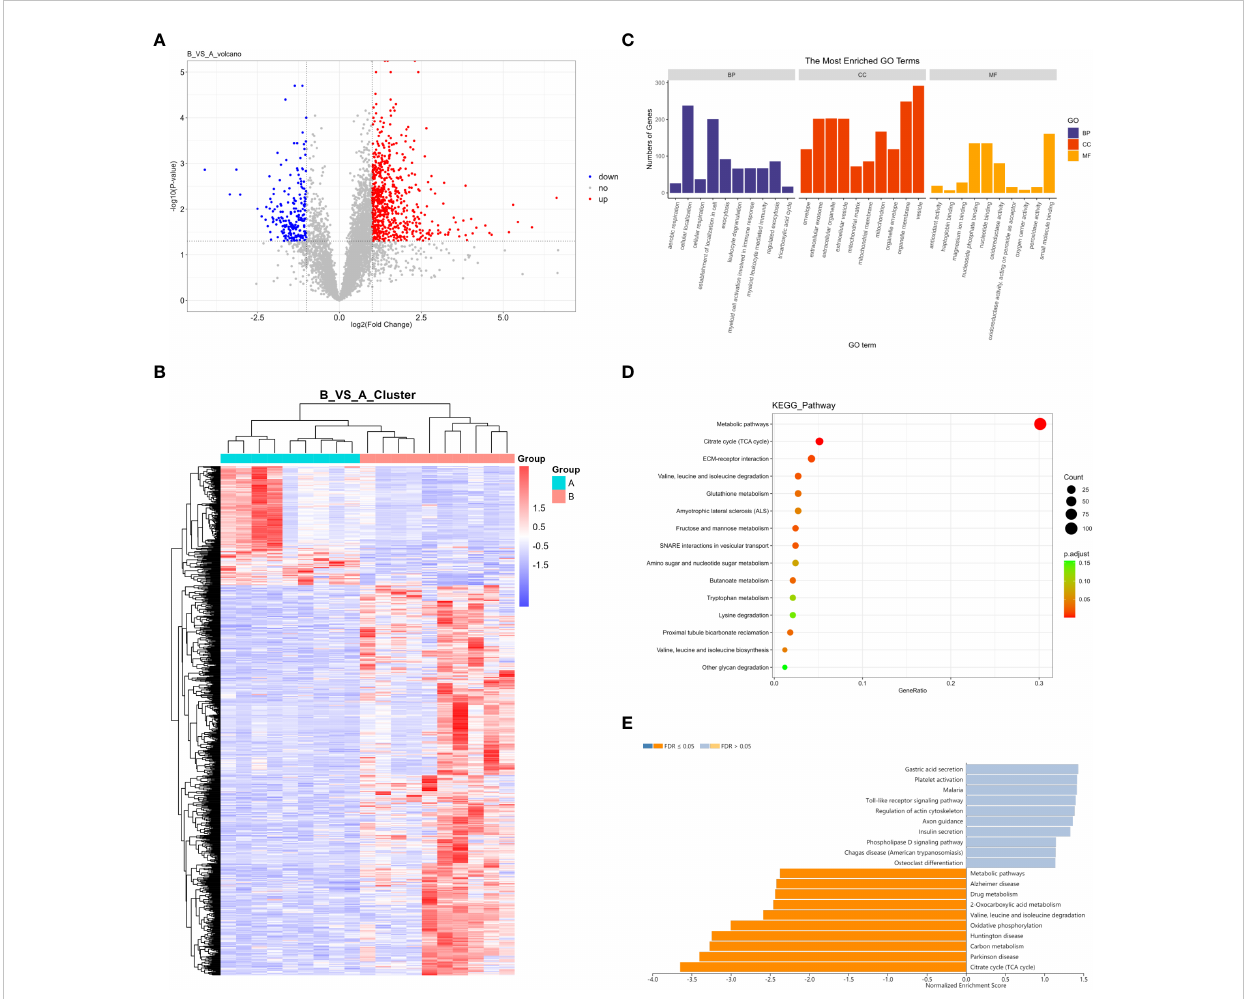
FIGURE 2 (A) Volcano map of DEPs; (B) Cluster analysis heat map of DEPs; (C) GO enrichment analysis of DEPs; (D) KEGG enrichment analysis of DEPs; (E) GSEA enrichment analysis of